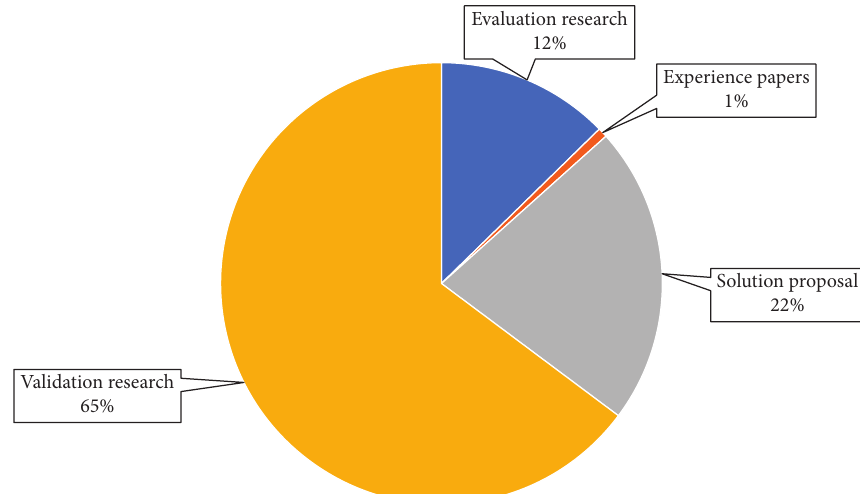
Figure 6: Research type